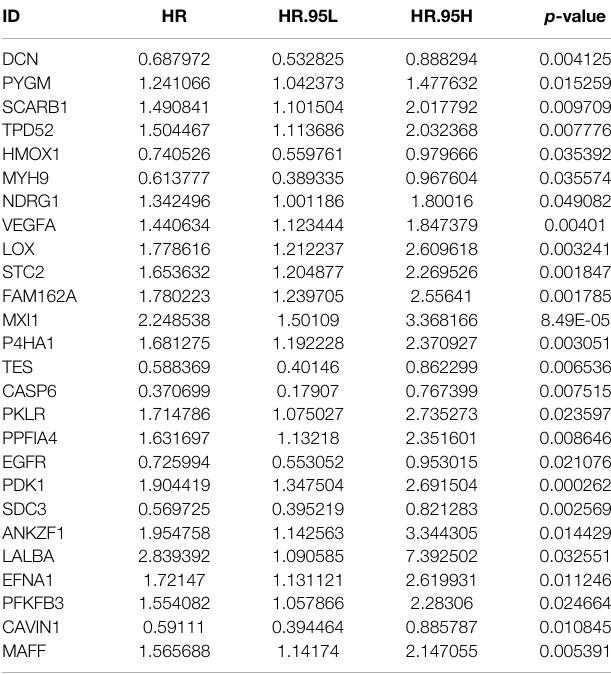
TABLE 1 | Univariate cox regression analysis for prognosis-related hypoxic genes in the TARGET cohort. ID